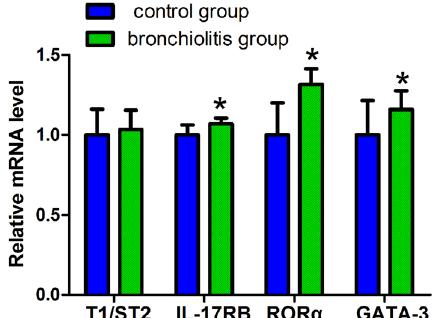
Figure 2. The mRNA expression levels of T1/ST2, IL-17RB, RORα, GATA-3 in control group and bronchiolitis group. IL-17RB, RORα, and GATA-3 mRNA expression levels in the bronchiolitis group were greater than control group (* P < 0.05), while there was no difference in T1/ST2 mRNA expression level between two groups ( P > 0.05).